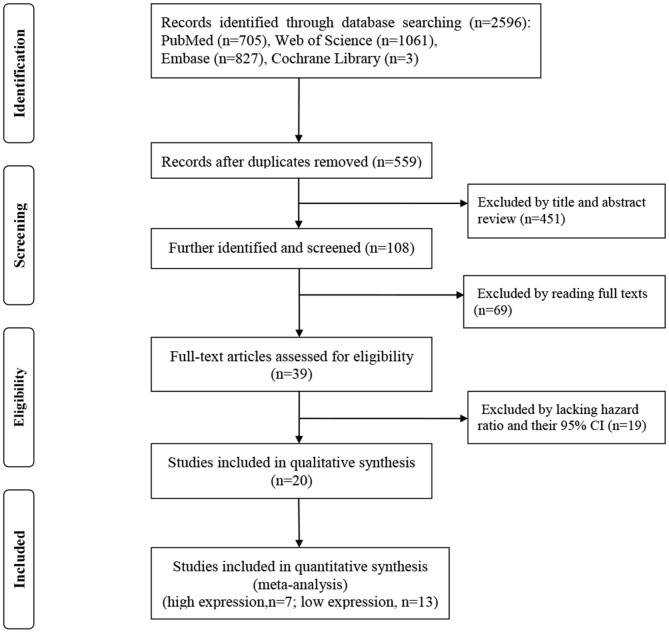
Flow-process diagram of the study selection process.